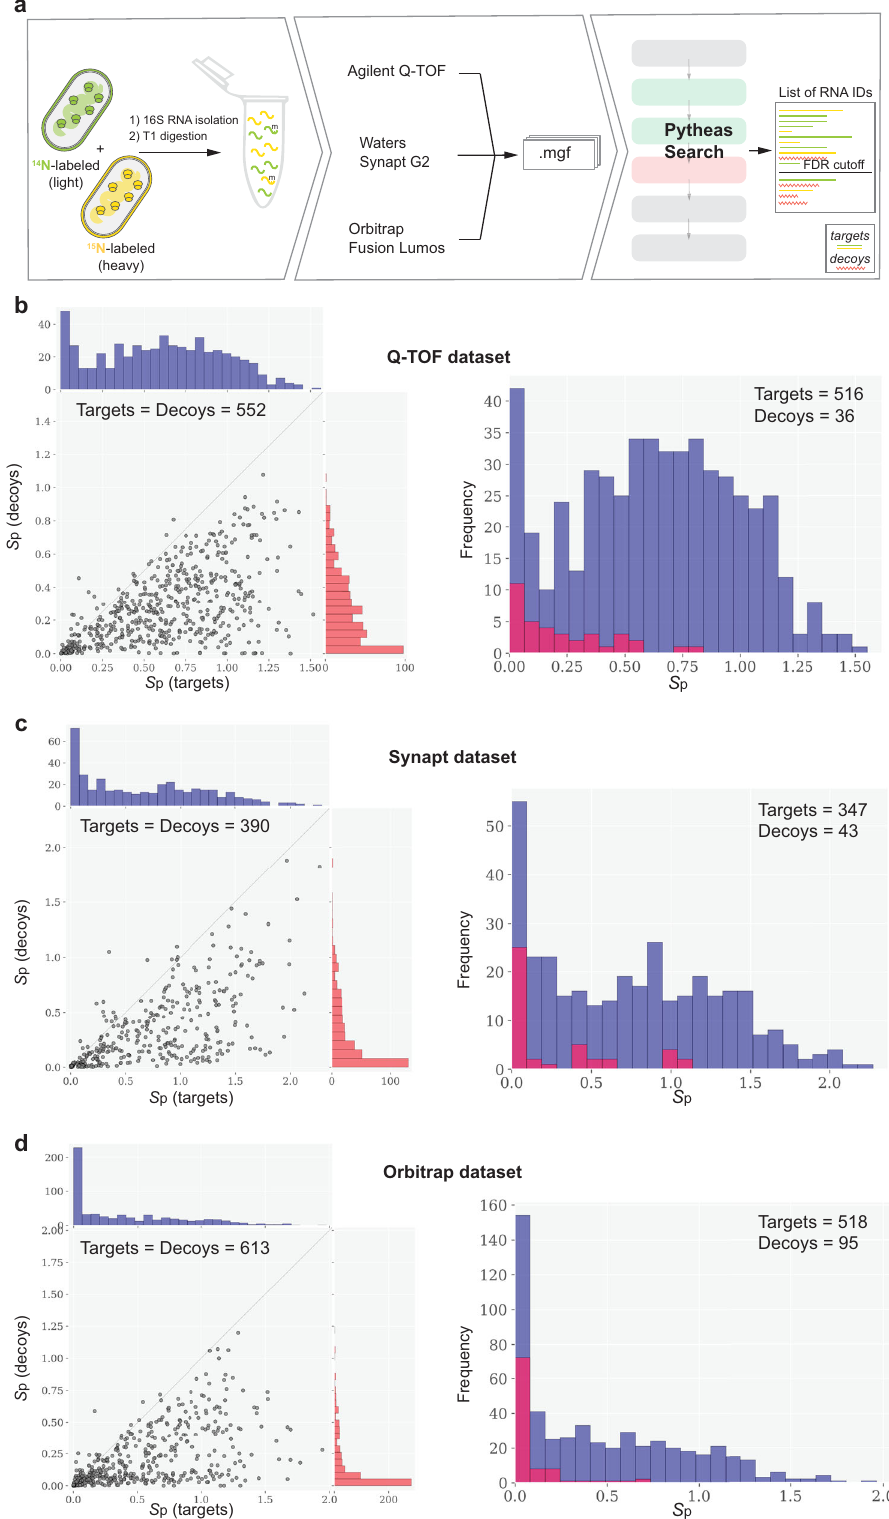
Fig. 3 Statistical assessment of the E. coli 16S data acquired on different MS instruments. a 16S sample preparation and analysis work fl ow. ( b – d , left) S p scatter plots of best matching targets vs their highest-scoring competing decoy sequences for Q-TOF, Synapt and Orbitrap datasets. Histograms on top show the S p score distributions of targets (blue) and decoys (red). ( b – d , right) Distributions of the S p scores for OSMs with rank = 1. Targets are in blue, and decoys are in red. b – d Light and heavy targets and decoys matches were used for analysis, with a total number shown on each fi gure. Targets with at least one competing decoy are shown on the plots, and targets without decoys are excluded. Source data are provided as a Source Data fi